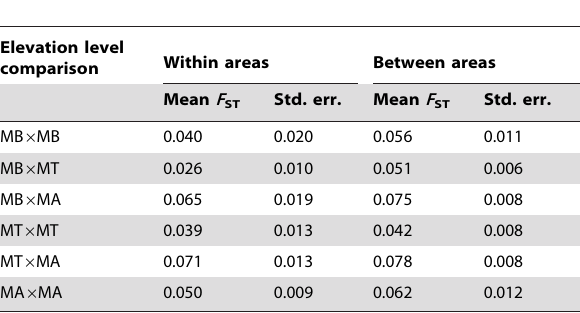
Table 3. Mean pairwise FST estimates between populations at altitudinal elevations of Agabus